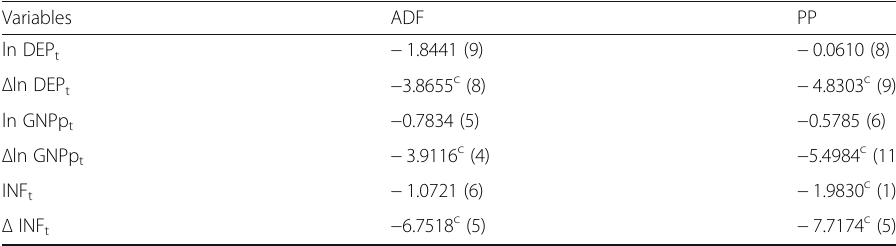
Table 1 Unit root estimation Variables